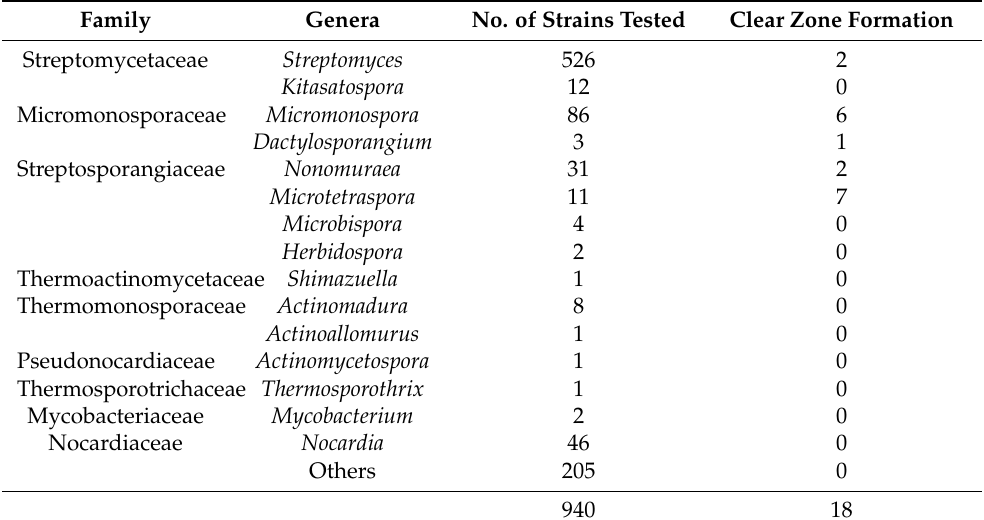
Table 1. Screening of Sarawak Biodiversity Centre (SBC) Actinobacteria Culture Collection for rubber